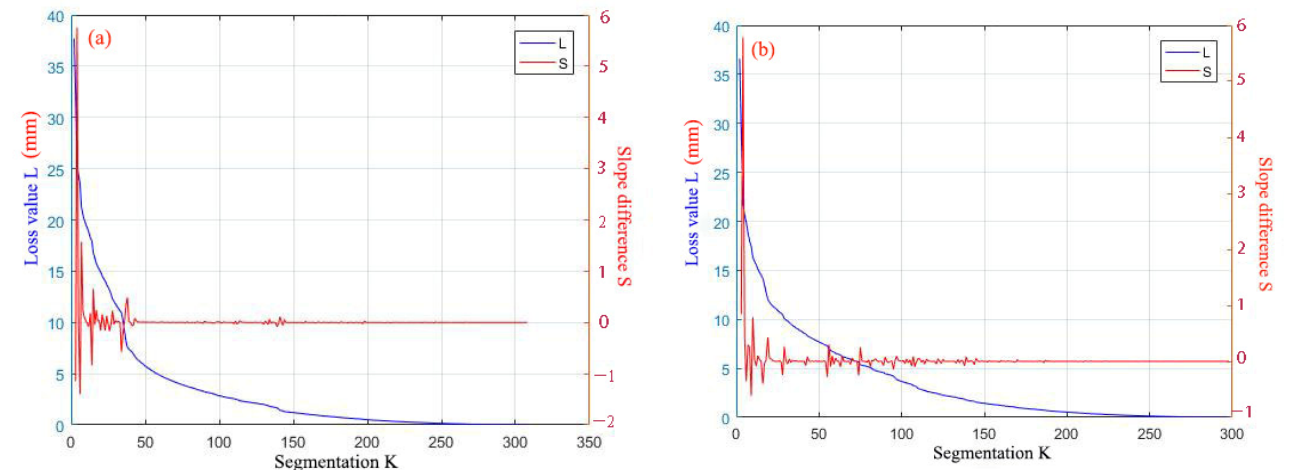
Figure 3. The results of Fisher optimal segmentation method under the different number of grids. ( a ) 100 grids; ( b ) 200 grids. ( a ) 100 grids; ( b ) 200